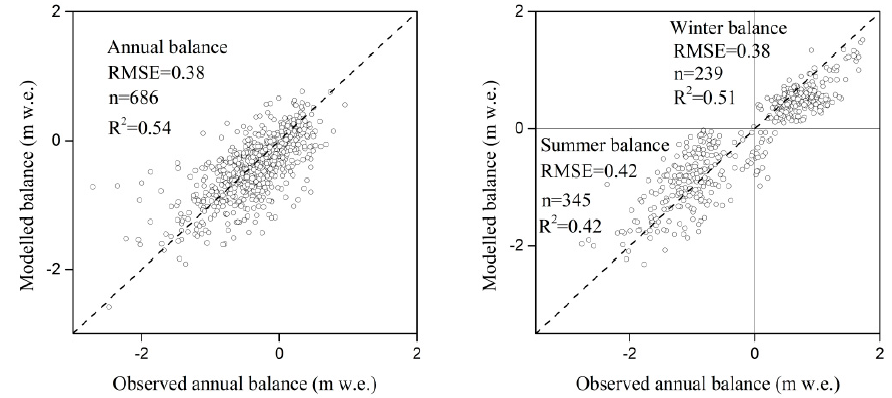
Figure 2. Comparison between modeled and observed annual, summer, and winter balance for each glacier and each year in our dataset.